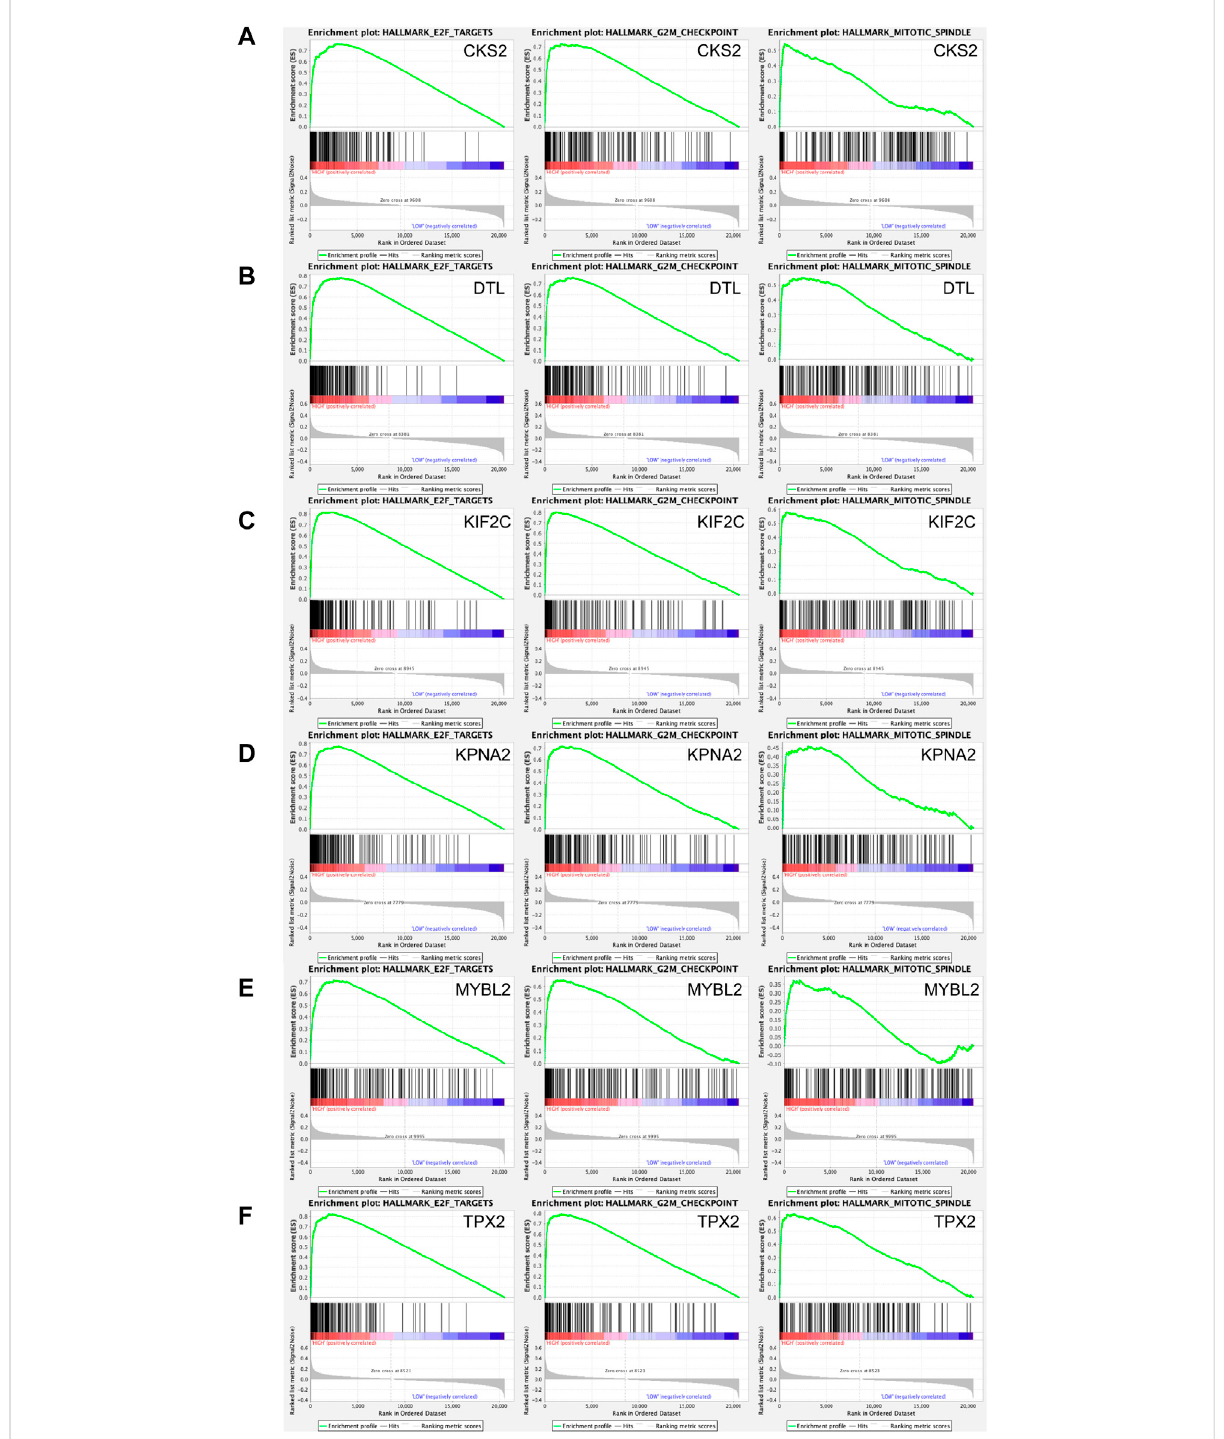
FIGURE 9 A total of 100 signi fi cant genes were obtained from GSEA with positive and negative correlations. GSEA was used to perform hallmark analyses in CKS2, DTL, KIF2C, KPNA2, MYBL2 and TPX2 , respectively. The most involved signi fi cant pathways included E2F targets, G2M checkpoint and mitotic